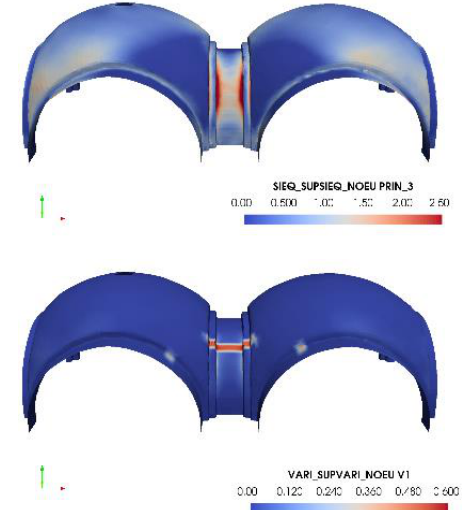
Figure 15. Analysis performed with the vertical displacement imposed on the central column on point cloud-derived 2D model: distribution of maximum principal stresses before cracking (Up) and the damage pattern